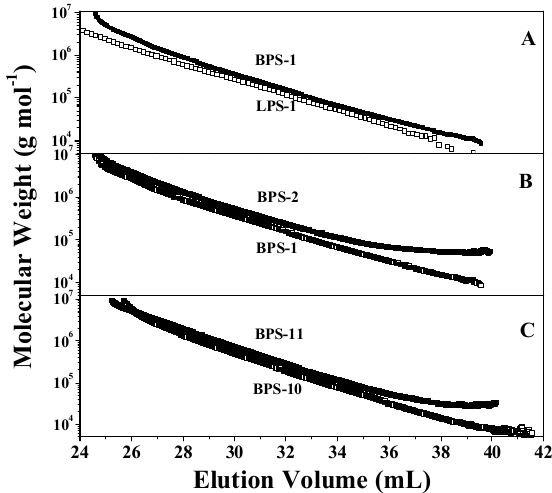
Figure 3. Plots of molecular weight versus elution volume.